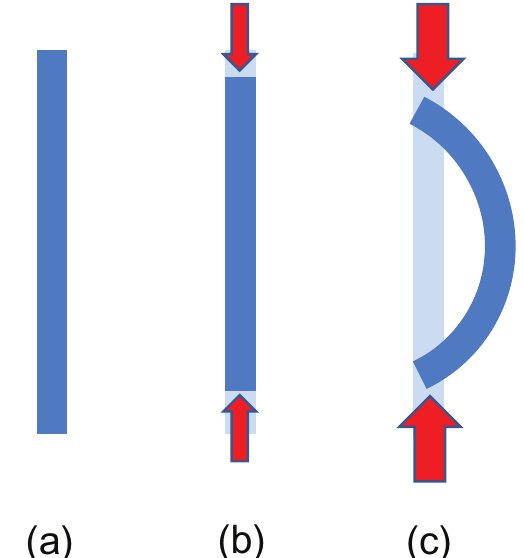
Figure 1. Schematic diagram of buckling of an elastic beam under axial compression: ( a ) pristine beam; ( b ) axial compression for a small load; ( c ) buckling observed beyond a critical